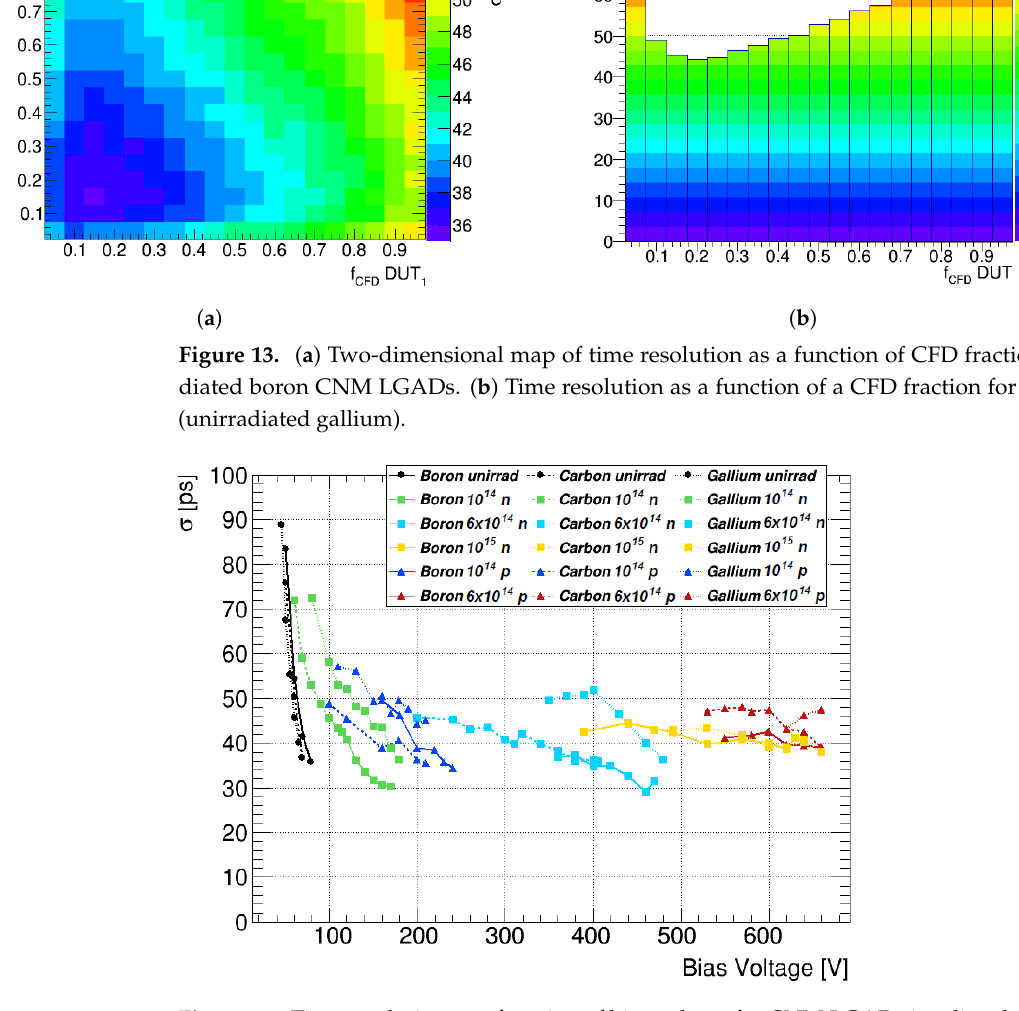
Figure 14. Time resolution as a function of bias voltage for CNM LGADs irradiated up to a fluence of 10 15 n eq /cm 2 at −